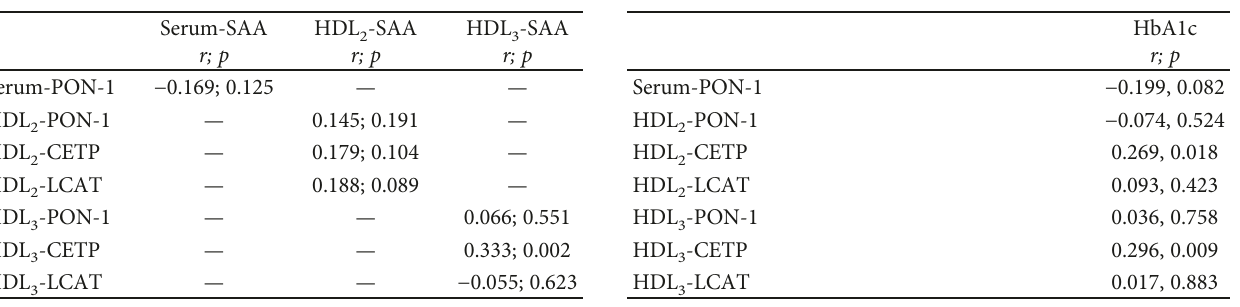
Table 4: Correlations between SAA- and HDL-associated proteins and enzymes ( n = 84 ).